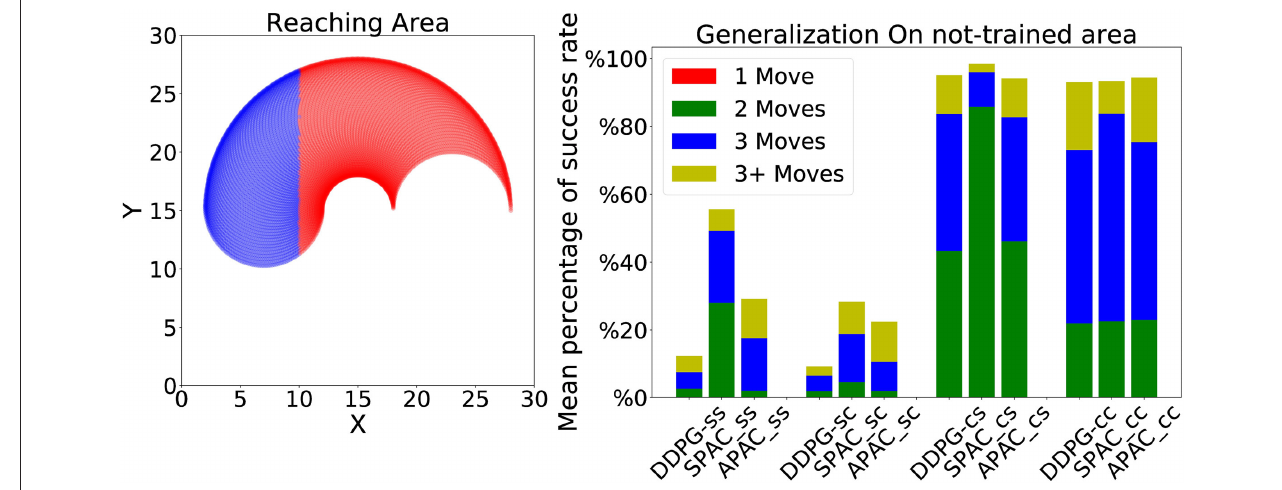
FIGURE 9 | (Left) The reaching area for arm under static kinematics conditions. The red area is used for training while the blue region is for testing. Around edges are more colored since these points can be reached with many more sets of angles. (Right) Performance of each model is shown under different conditions to reach about 40 targets located in the blue region. All models obtain a good generalization under changing target conditions.